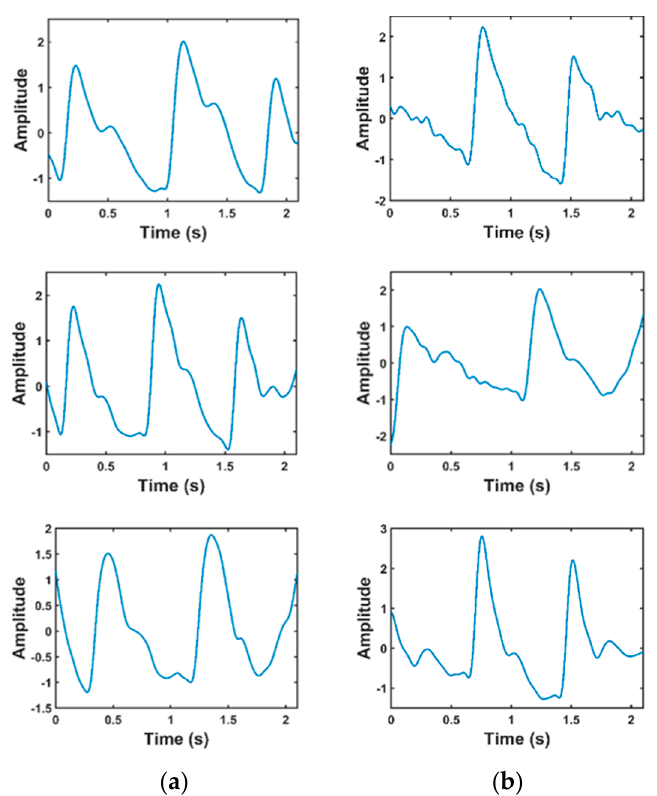
Figure 3. Comparison of waveforms that are fit and unfit for the study. ( a ) Fit data; ( b ) unfit data.